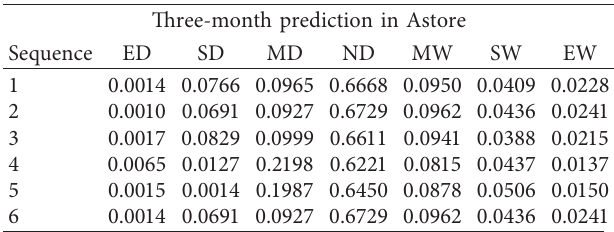
Table 4: Predicting future three-step transitions from the last state for various drought sequences at Astore station Three-month prediction in Astore